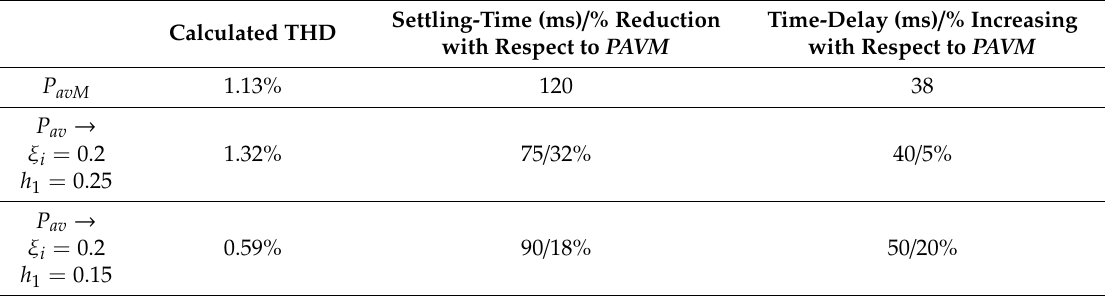
Table 4. THD, settling-time, and time-delay for the simulation of Pav. Calculated